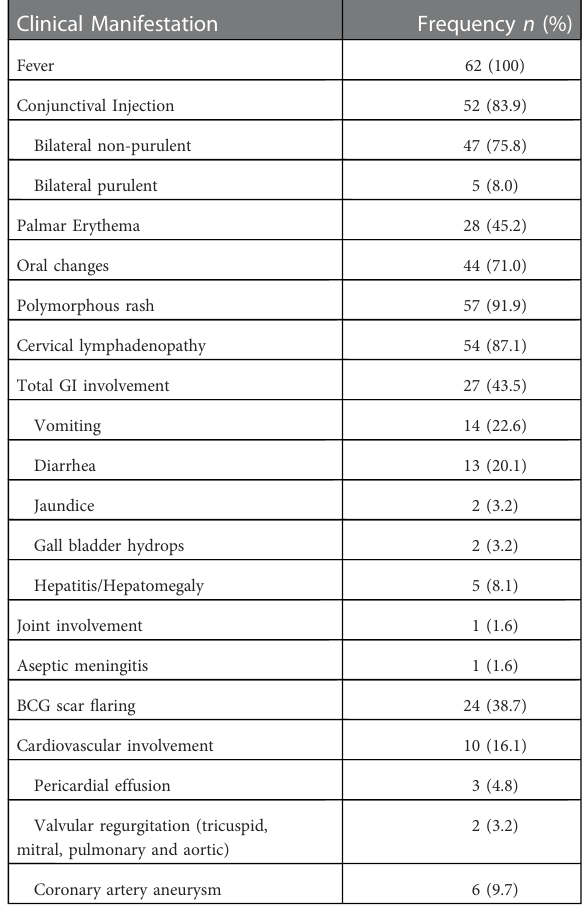
TABLE 2 Laboratory parameters in complete KD and incomplete KD